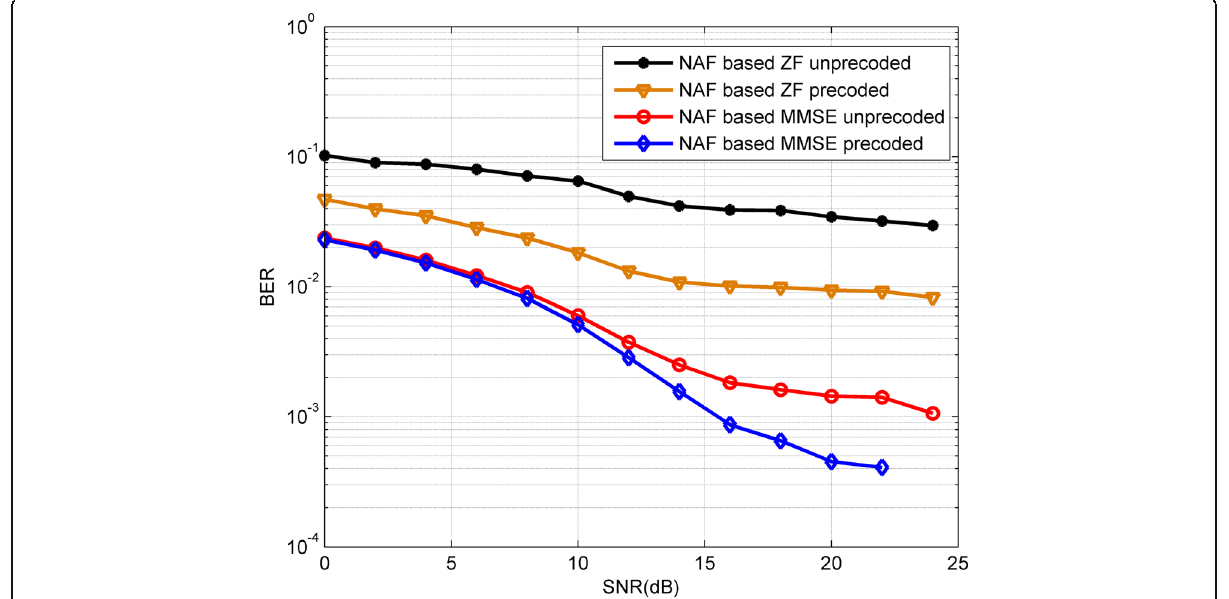
Fig. 3 The performance comparison of NAF MIMO relaying system with MMSE and ZF